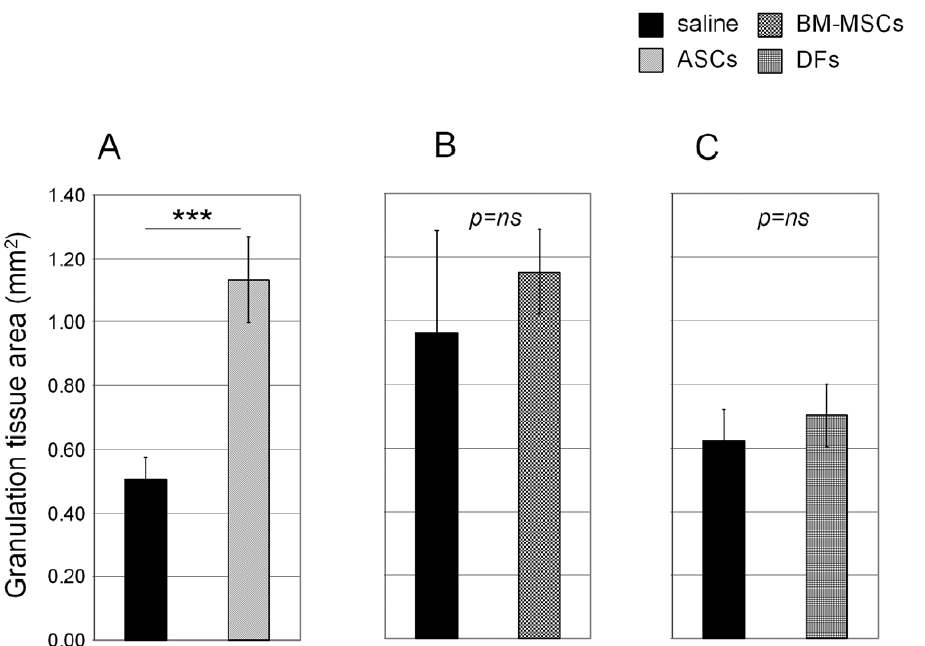
Figure 3. Histological quantification of MSCs treated wounds. (A–C): A total of 1 6 10 5 ASCs (A), BM-MSCs (B), and DFs (C) in PBS were delivered to 7 mm wounds on one ear. In the contralateral ear, PBS alone was delivered as a control. Wounds were harvested at POD7 and granulation tissue area was measured. Number of wounds analyzed; (A, n=35 for saline & n=36 for ASCs; B, n=17 for saline & n=20 for BM-MSCs, C, n=17 for saline & n=24 for DFs). N represents the total number of wounds from six (A) or four (B, C) rabbits. Data shown as mean + SEM. ***p , 0.001, ns=not significant.